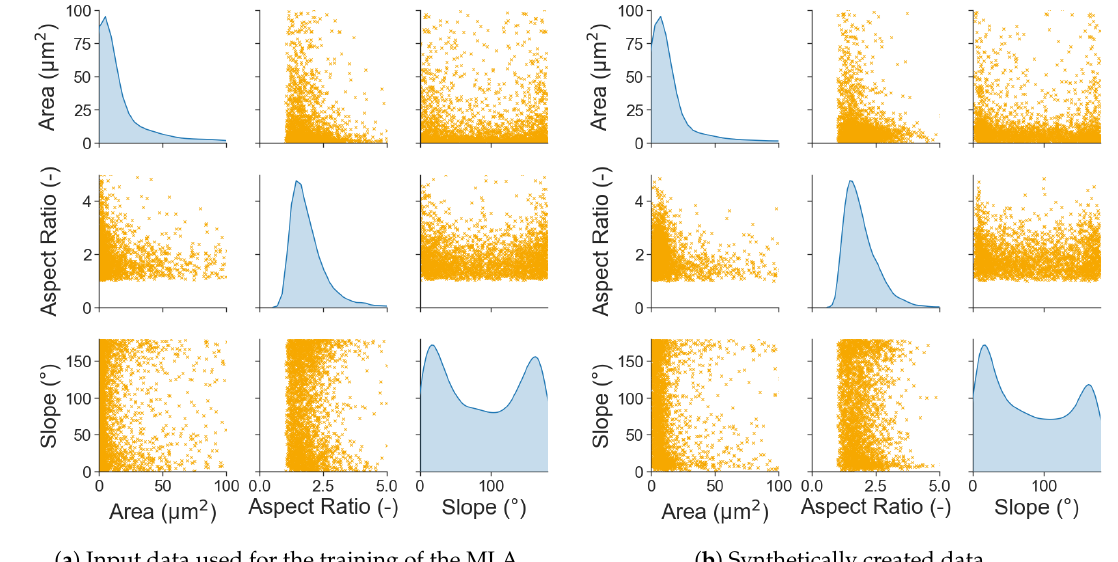
Figure 7. Comparison between the input data used for the training of the MLA and the output of the generator network at its best fit epoch. Dependencies between the different microstructural parameters shown for a better evaluation of the results.